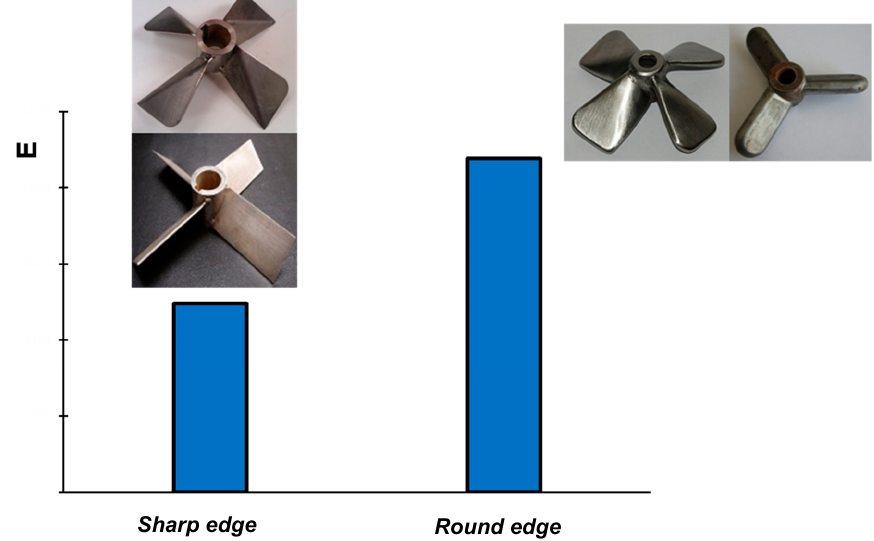
Figure 18. Illustration of the influence of blade edge rounding due to enameling on increase of the energetic requirement for particle suspension and homogenization (E) in comparison with a standard welded blade.